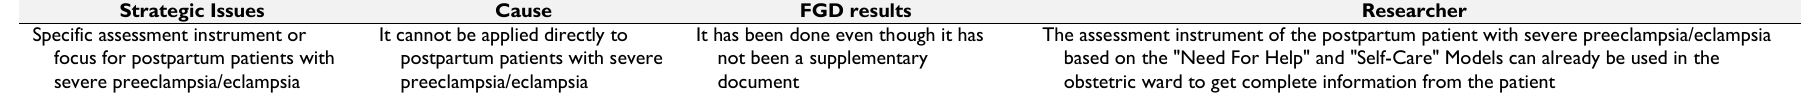
Table 6 Second FGD